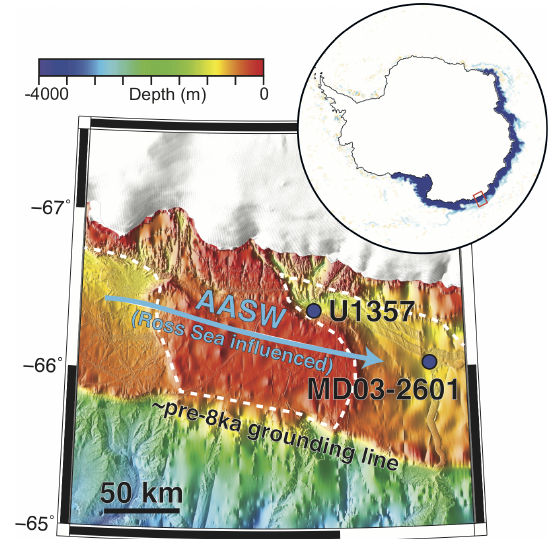
Figure 1. Location of sites U1357 and MD03-2601 (blue dots). The ice sheet grounding line formed a calving-bay environment (dashed white line) prior to 11.4ka, but since at least 8.2ka Antarctic Sur- face Water flow is largely advected from the Ross Sea (blue line). The inset map shows the pathway of freshwater (dark blue) after 1 year of 1Sv meltwater released from along the edge of the Ross Ice Shelf in a model